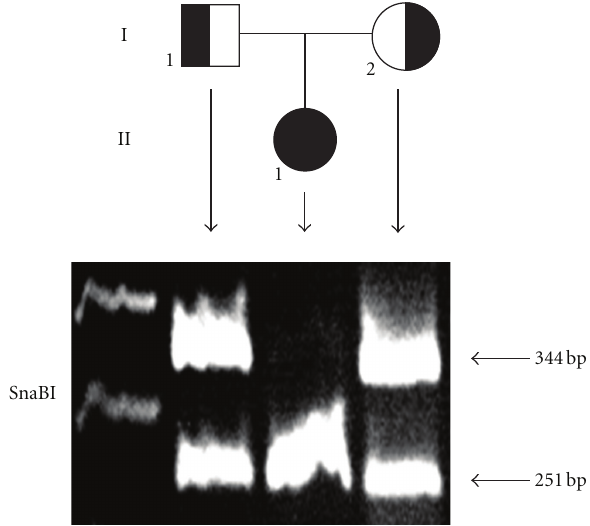
Figure 2: Molecular analysis of genomic DNA identified a homozy- gous one-base pair deletion (T313del) in exon 3 of the TSH β subunit gene resulting in a frame shift and a premature stop at codon 114. The deletion of nucleotide 313 (T) creates a new restriction site for SnaBI. The allele with the wild-type TSH β fragment remained undigested (344 bp), whereas the mutant allele was cut into two fragments of 251 (as shown in the figure) and 93 bp (not shown). Our patient (II1) is homozygous for this mutation, both parents (I1 and I2) are